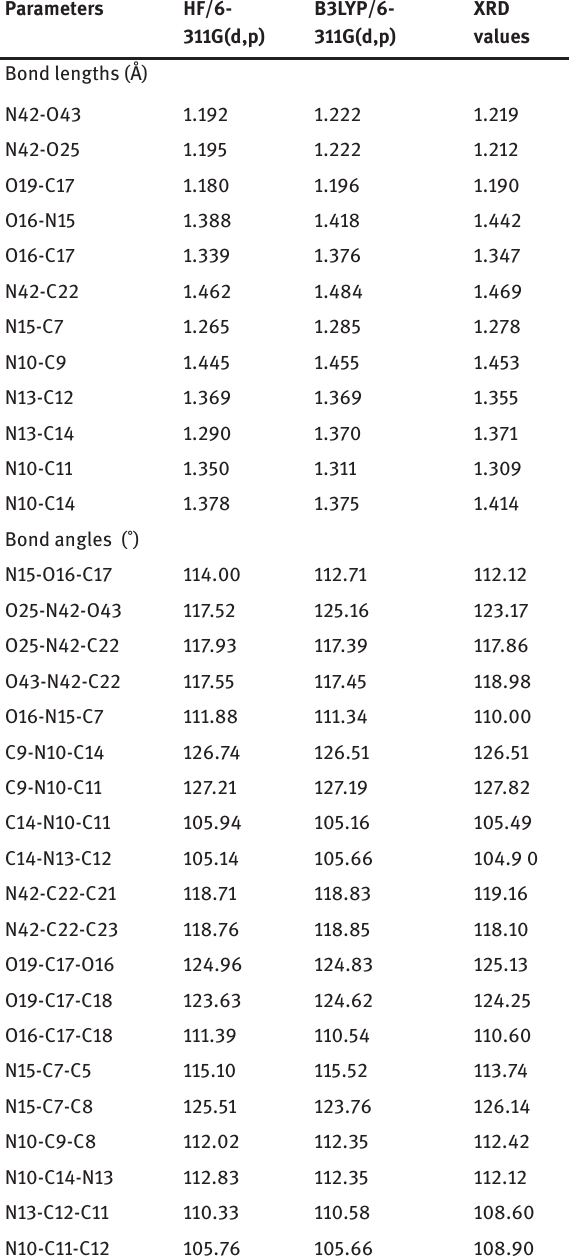
Table 1: Selected optimized geometrical parameters and XRD values of bond lengths (Å) and bond angles (˚) of the IPAONM molecule.